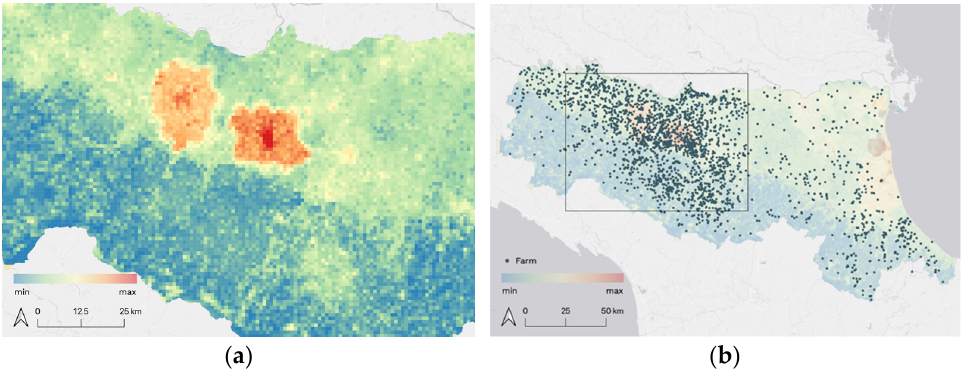
Figure 5. Presence of farms. In this image it is possible to see how the concentration of farms ( b ) settles in Parma and Reggio–Emilia ( a ), characterised by a positive balance due to the high number of dairy farms.